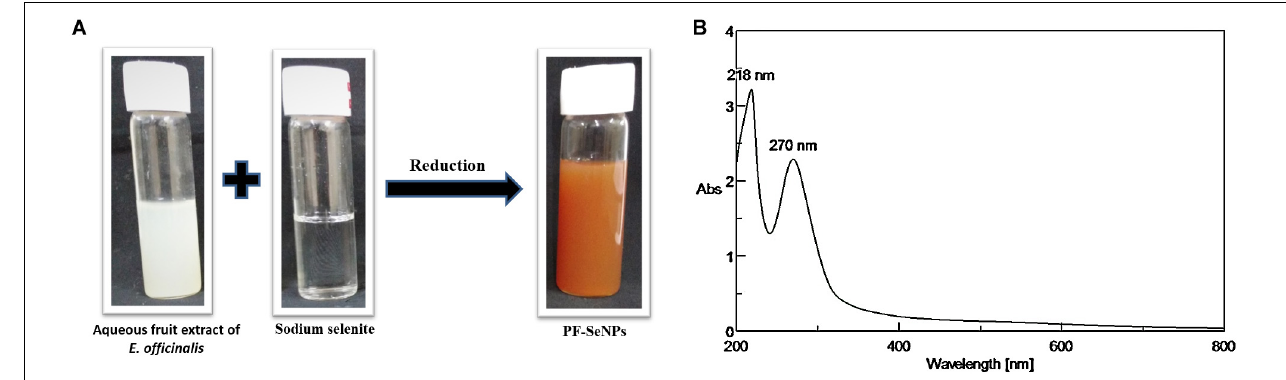
FIGURE 2 | (A) Reduction of sodium selenite by aqueous fruit extract of E. officinalis to form phytofabricated selenium nanoparticles (PF-SeNPs). (B) UV-visible spectra of biogenic